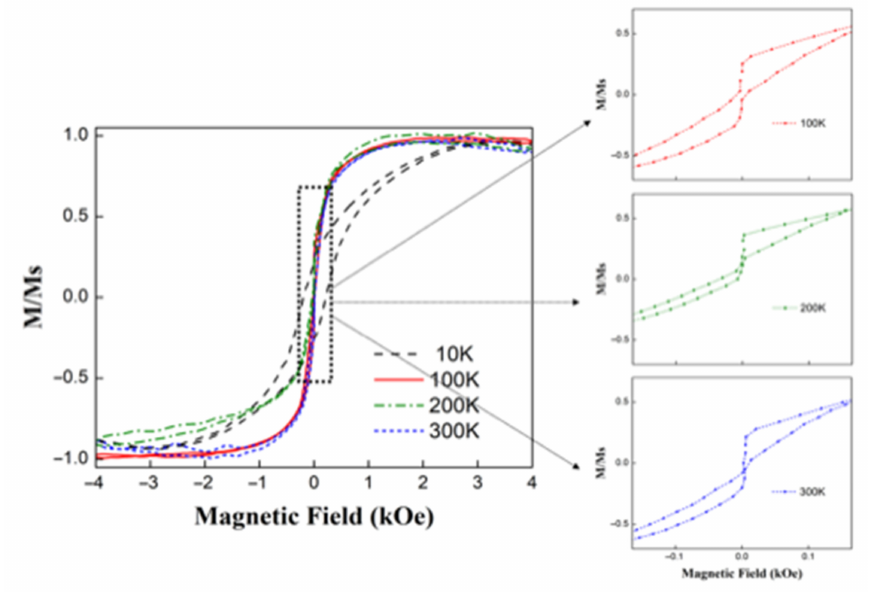
Figure 7. Hysteresis curves for hollow Fe 3 O 4 nanospheres obtained at different temperatures.